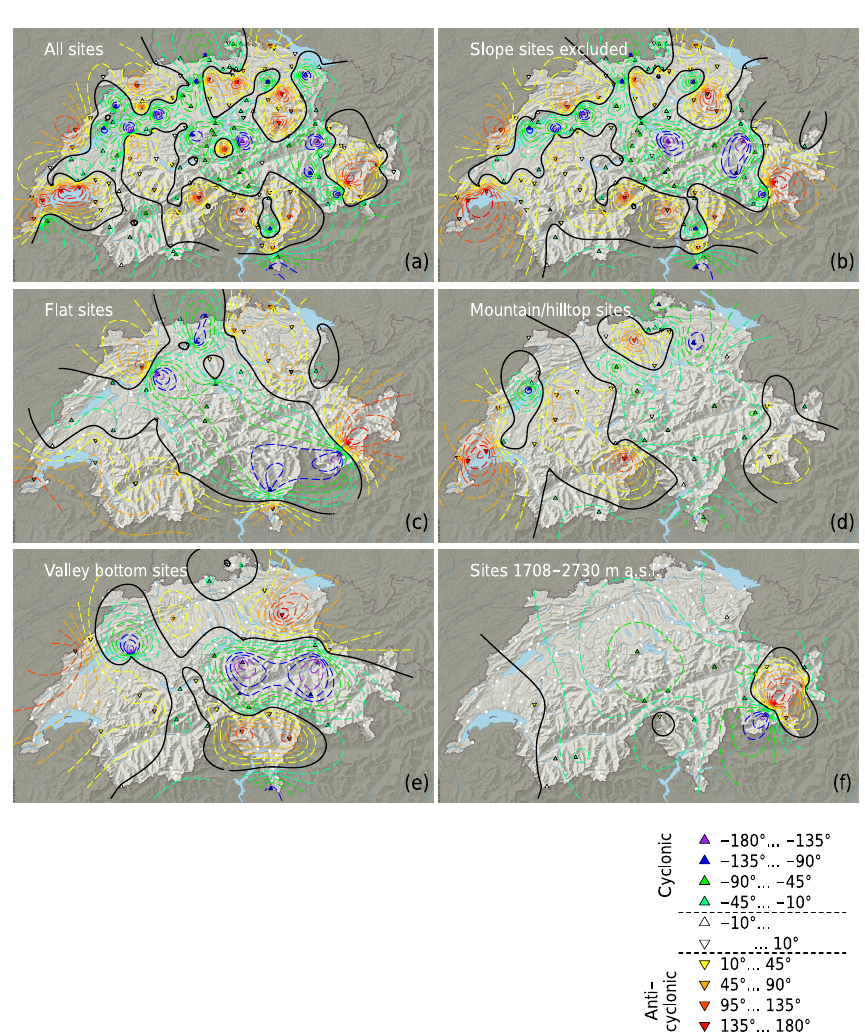
Figure 10. Spatial distribution of wind direction changes over Switzerland during the 20 March 2015 eclipse. Yellowish to reddish colors indicate anticyclonic rotation, while greenish to bluish colors indicate cyclonic rotation. The bold and broken isolines show lines of equal rotation angle at 20 ◦ intervals. The bold line separates areas with cyclonic from anticyclonic wind direction changes. Base map from Atlas of Switzerland V3 (Hurni, 2010), © 2016 swisstopo